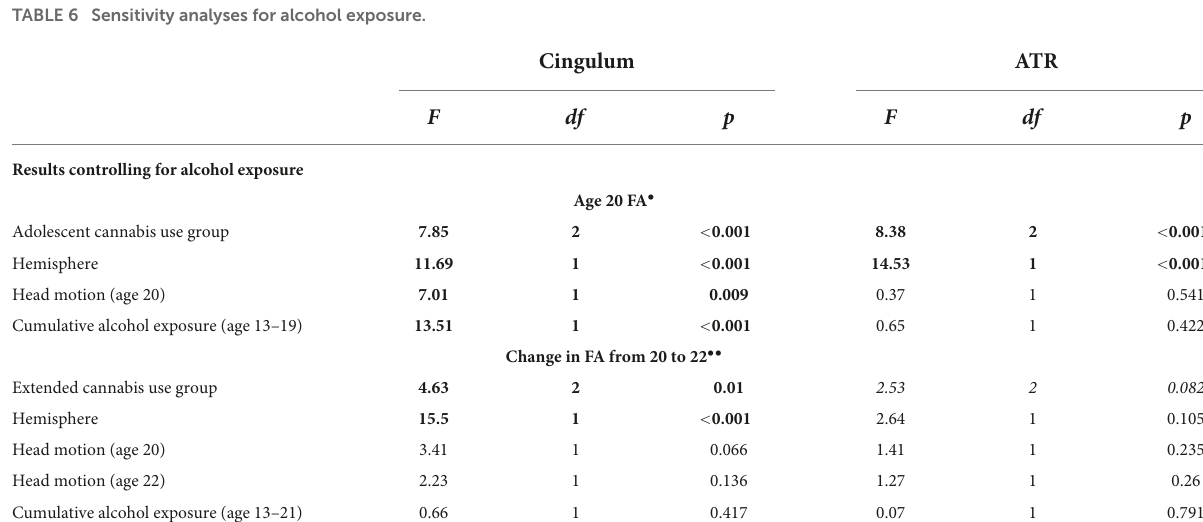
TABLE 6 Sensitivity analyses for alcohol